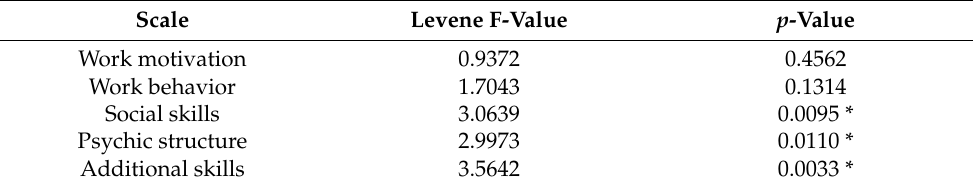
Table 14. Levene test statistics when the sample is differentiated by the area of knowledge. Scale Levene F-Value p -Value Work motivation